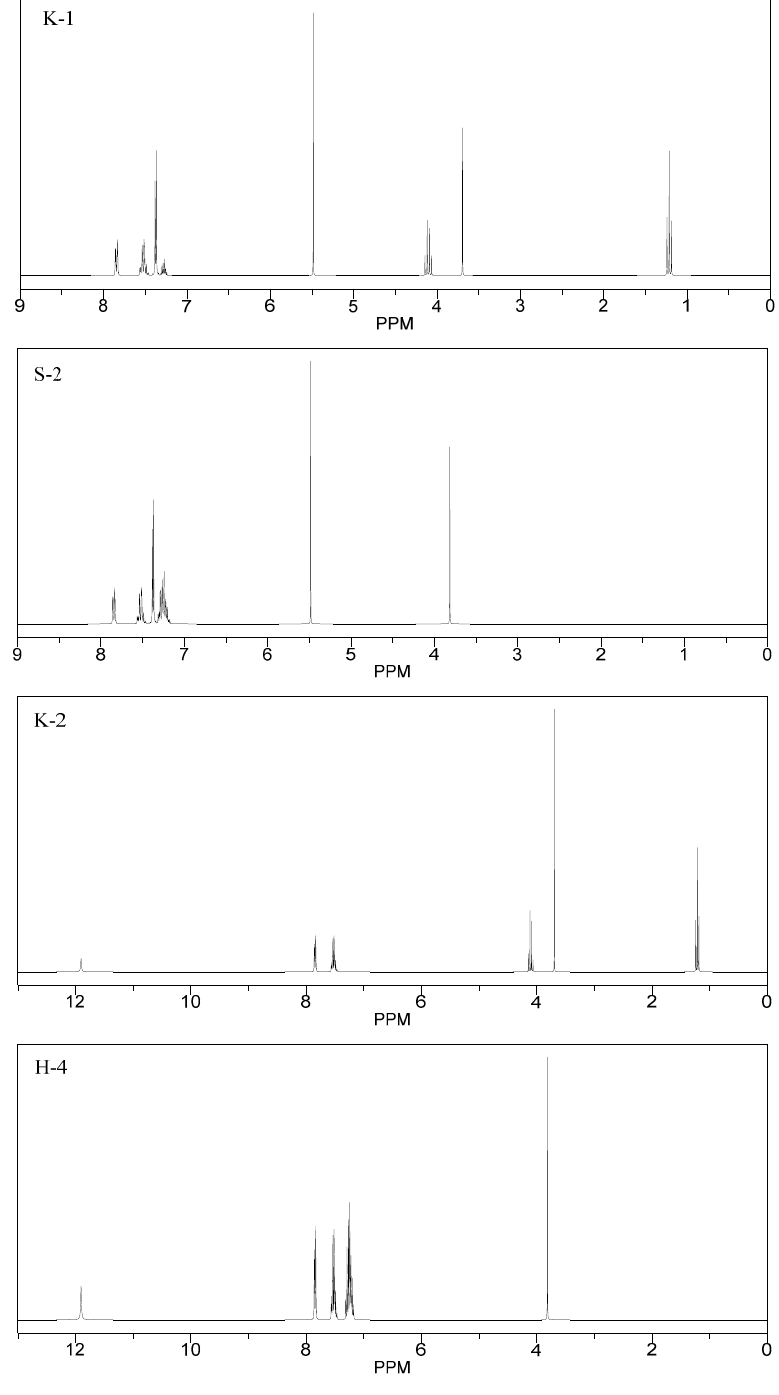
Figure 4. 1 H-NMR spectra of synthesis compounds.